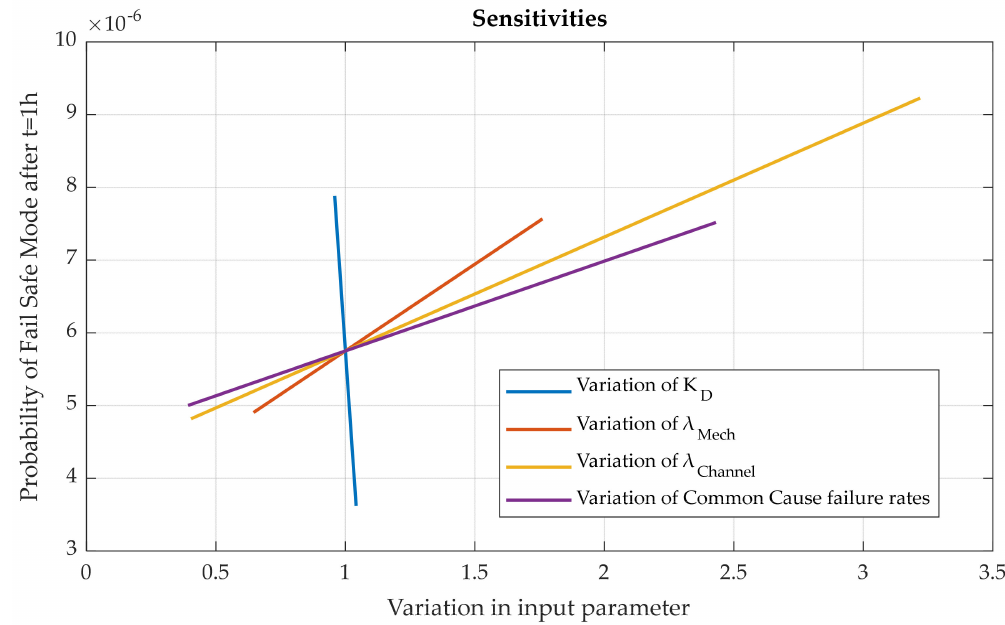
Figure 3. Sensitivity study based on the Markov analysis of the fault-tolerant EMA architecture.